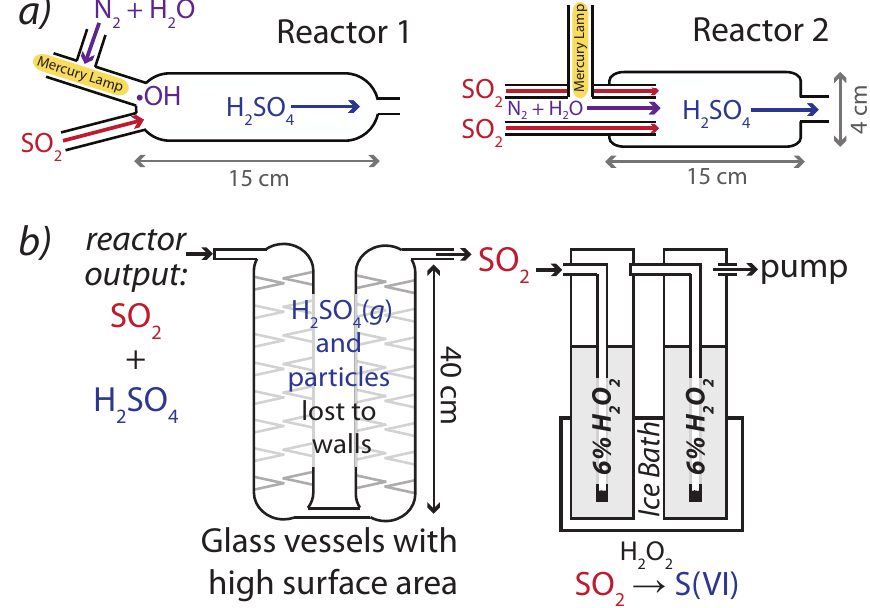
Fig. 1. Reaction system used to investigate oxidation of SO 2 : (a) reactors, (b) collection